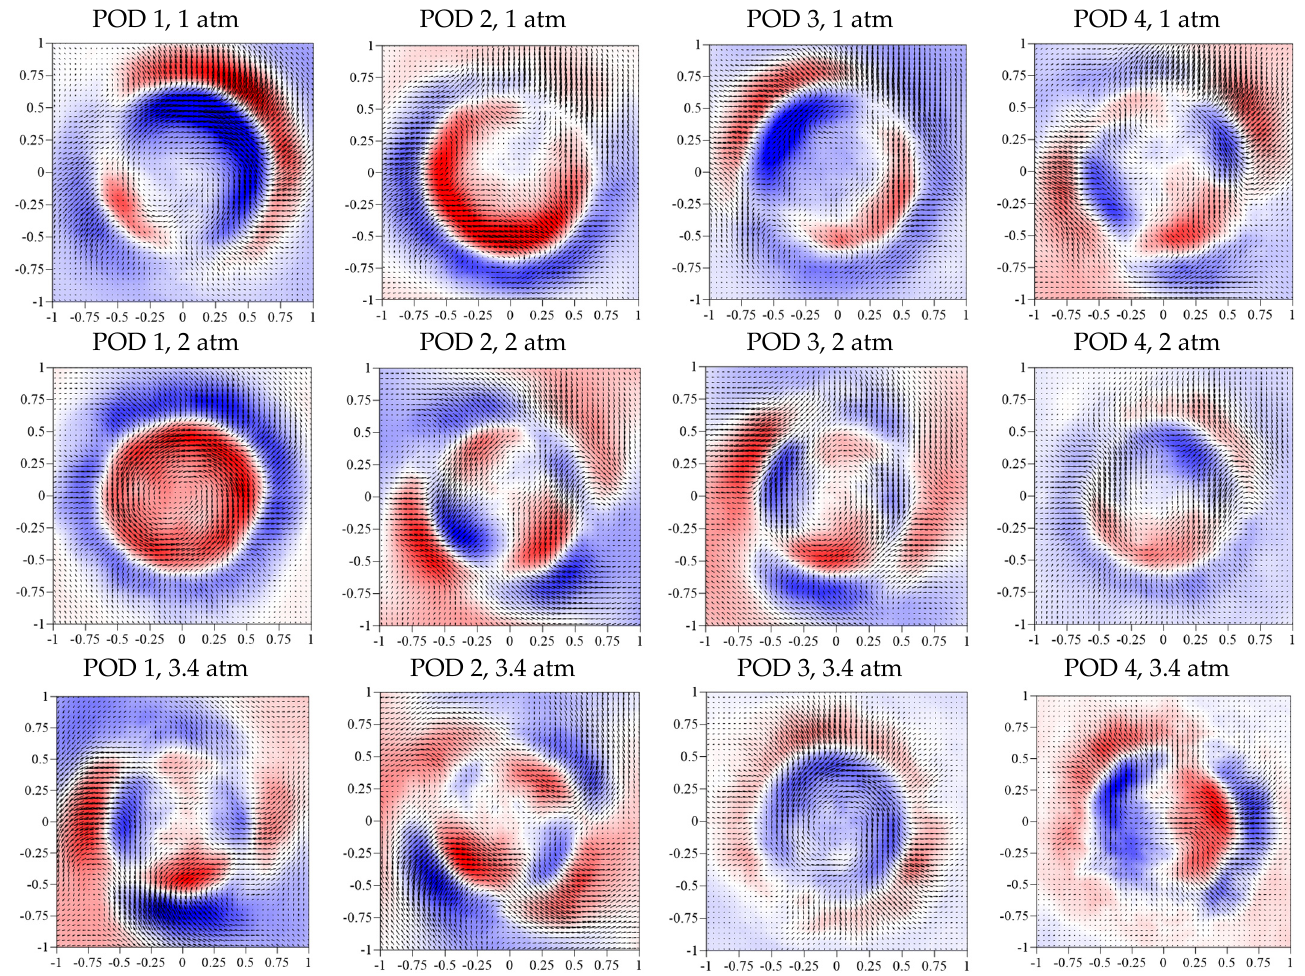
Figure 17. First four POD modes of the velocity variations (color scale demonstrates the out of plane velocity component variations) at a distance 1D from the nozzle exit.